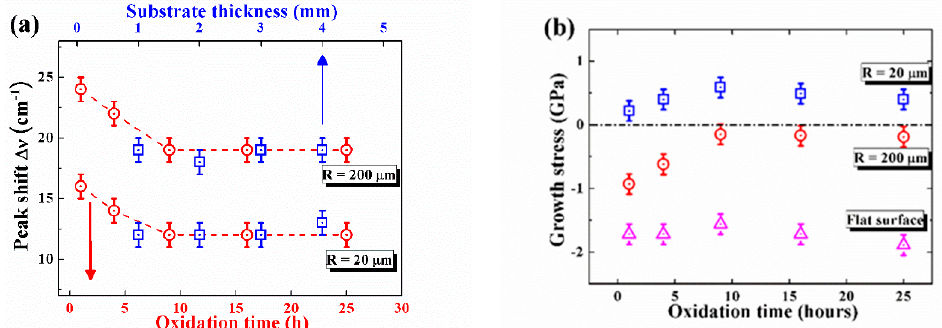
Figure 5. ( a ) Peak shift of the characteristic R-line of α -Al 2 O 3 scale at the indents with 20 µ m and 200 µ m radii as a function of oxidation time at 1200 ◦ C with circle symbols (given a substrate thickness of 2 mm) and substrate thickness with square symbols (given an oxidation period of 25